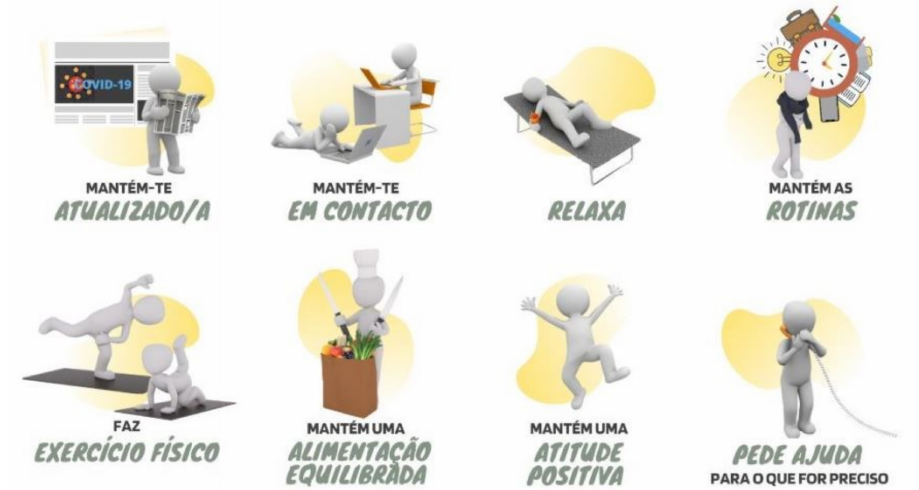
Figure 1. Intervention strategies of the Adolescer Guide. Note: The image shows the original page from “Adolescer”, representing the eight practices written in Portuguese. Following the order from left to right, in English the figures translate to: (i) “keep yourself updated”; (ii) “keep in touch”; (iii) “relax”; (iv) “keep a daily routine”; (v) “practice physical exercise”; (vi) “maintain a healthy diet”; (vii) “stay positive” and (viii) “ask for help when needed”.